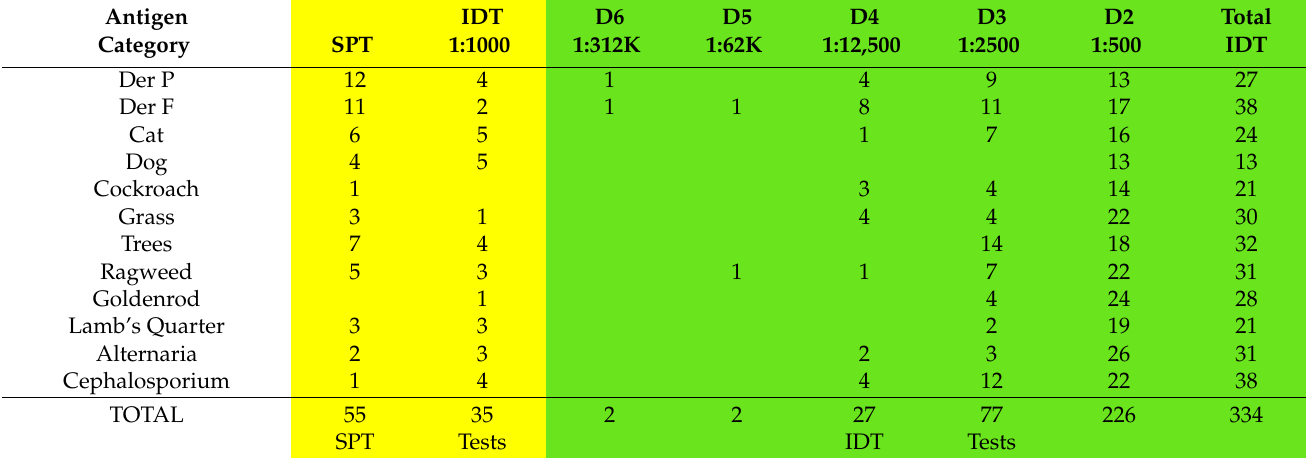
Figure 2. Comparative skin test results in 39 patients who initially had SPT and subsequently had IDT. The number of positive skin test reactions to each of 12 allergens following testing by both SPT and IDT. In comparison, their IDT results showed 334 positive and 134 negative. Individual antigen test comparisons for these 39 are shown in Table 3. Table 3. Comparison of number of positive antigen test results from 39 patients tested by both SPT and IDT. Antigen